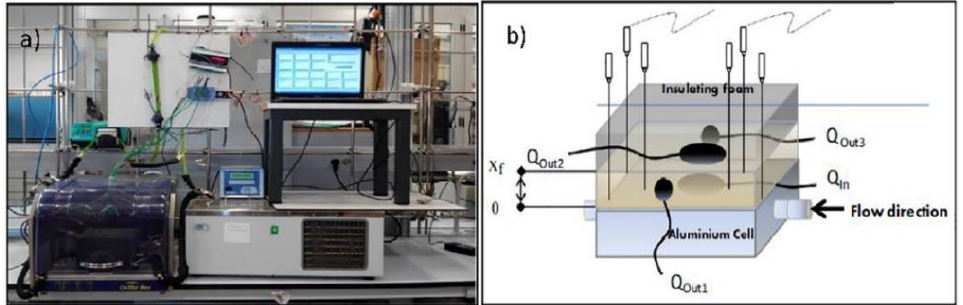
Figure 1. ( a ) Experimental device for the materials thermal behavior tests. ( b ) Temperature and heat flux sensors positions.